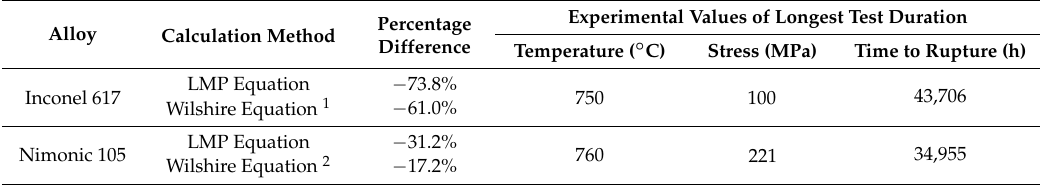
Table 11. Percentage differences of the calculated rupture times for the longest test durations.